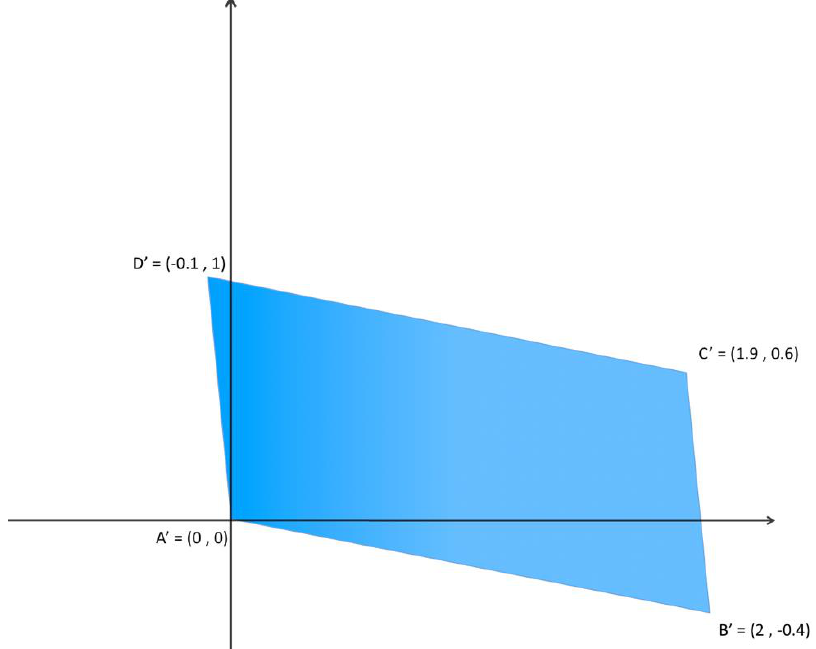
Figure 2. Initial payoff space: collection of all possible payoff scenarios, in a purely competitive framework, with z = 0.